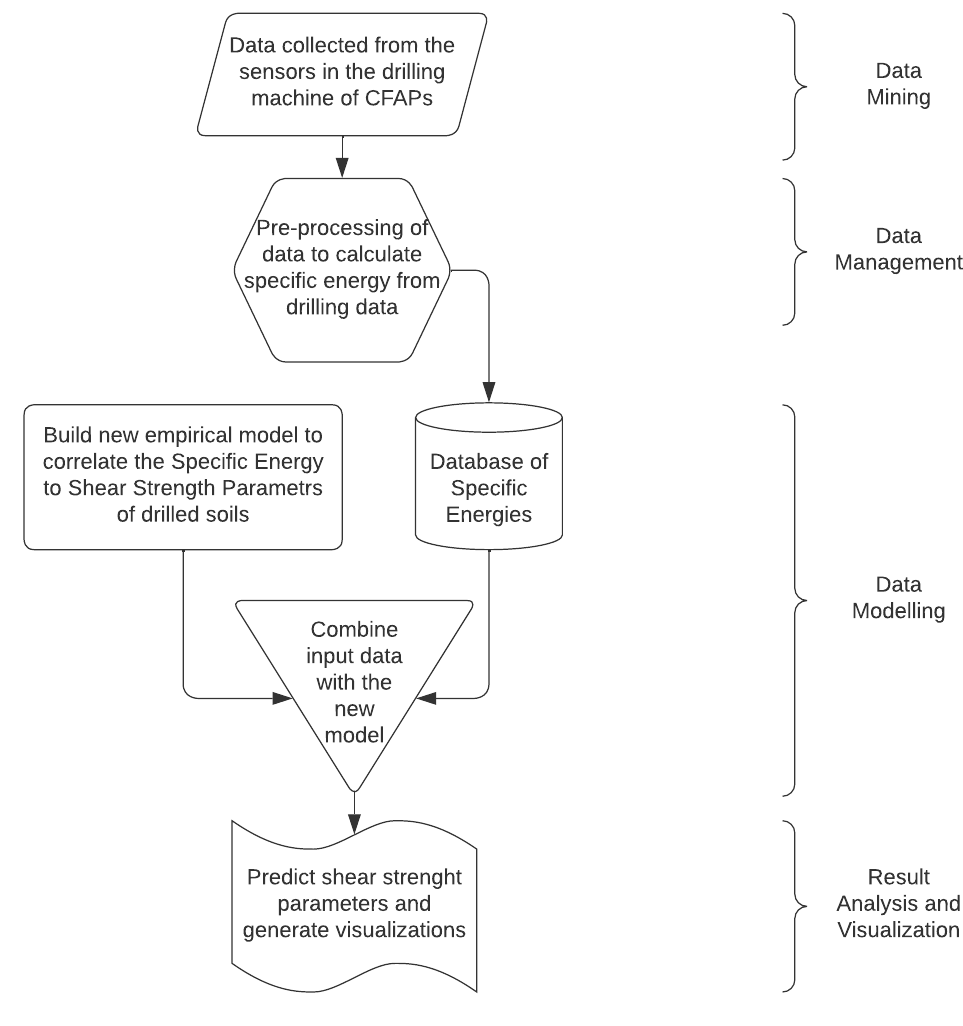
Figure 1. Methodological